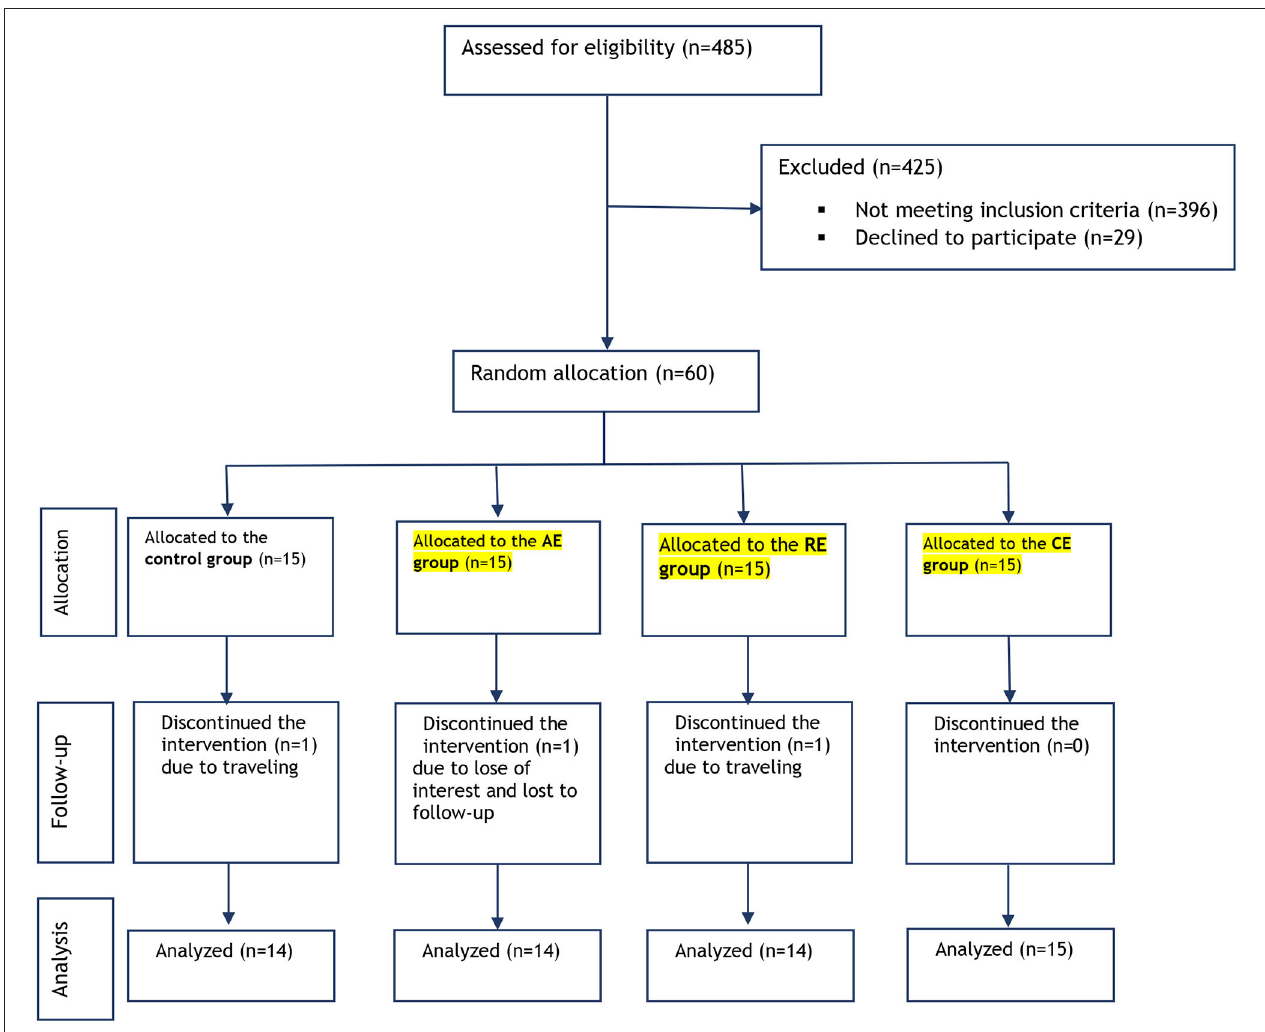
FIGURE 1 | Study flow